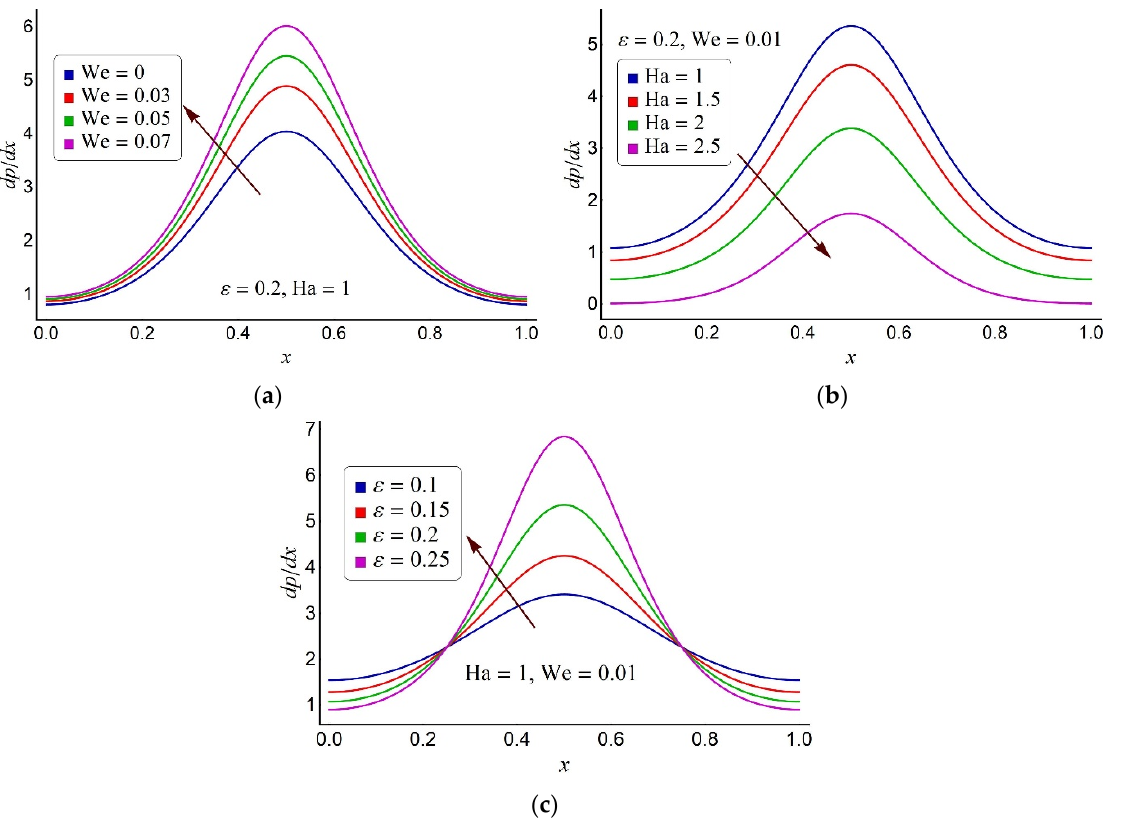
Figure 3. Alterations in the pressure gradient profile for distinct values of ( a ) Weissenberg number (We), ( b ) Hartmann number (Ha), and ( c ) cilia length parameter ( ε ) .